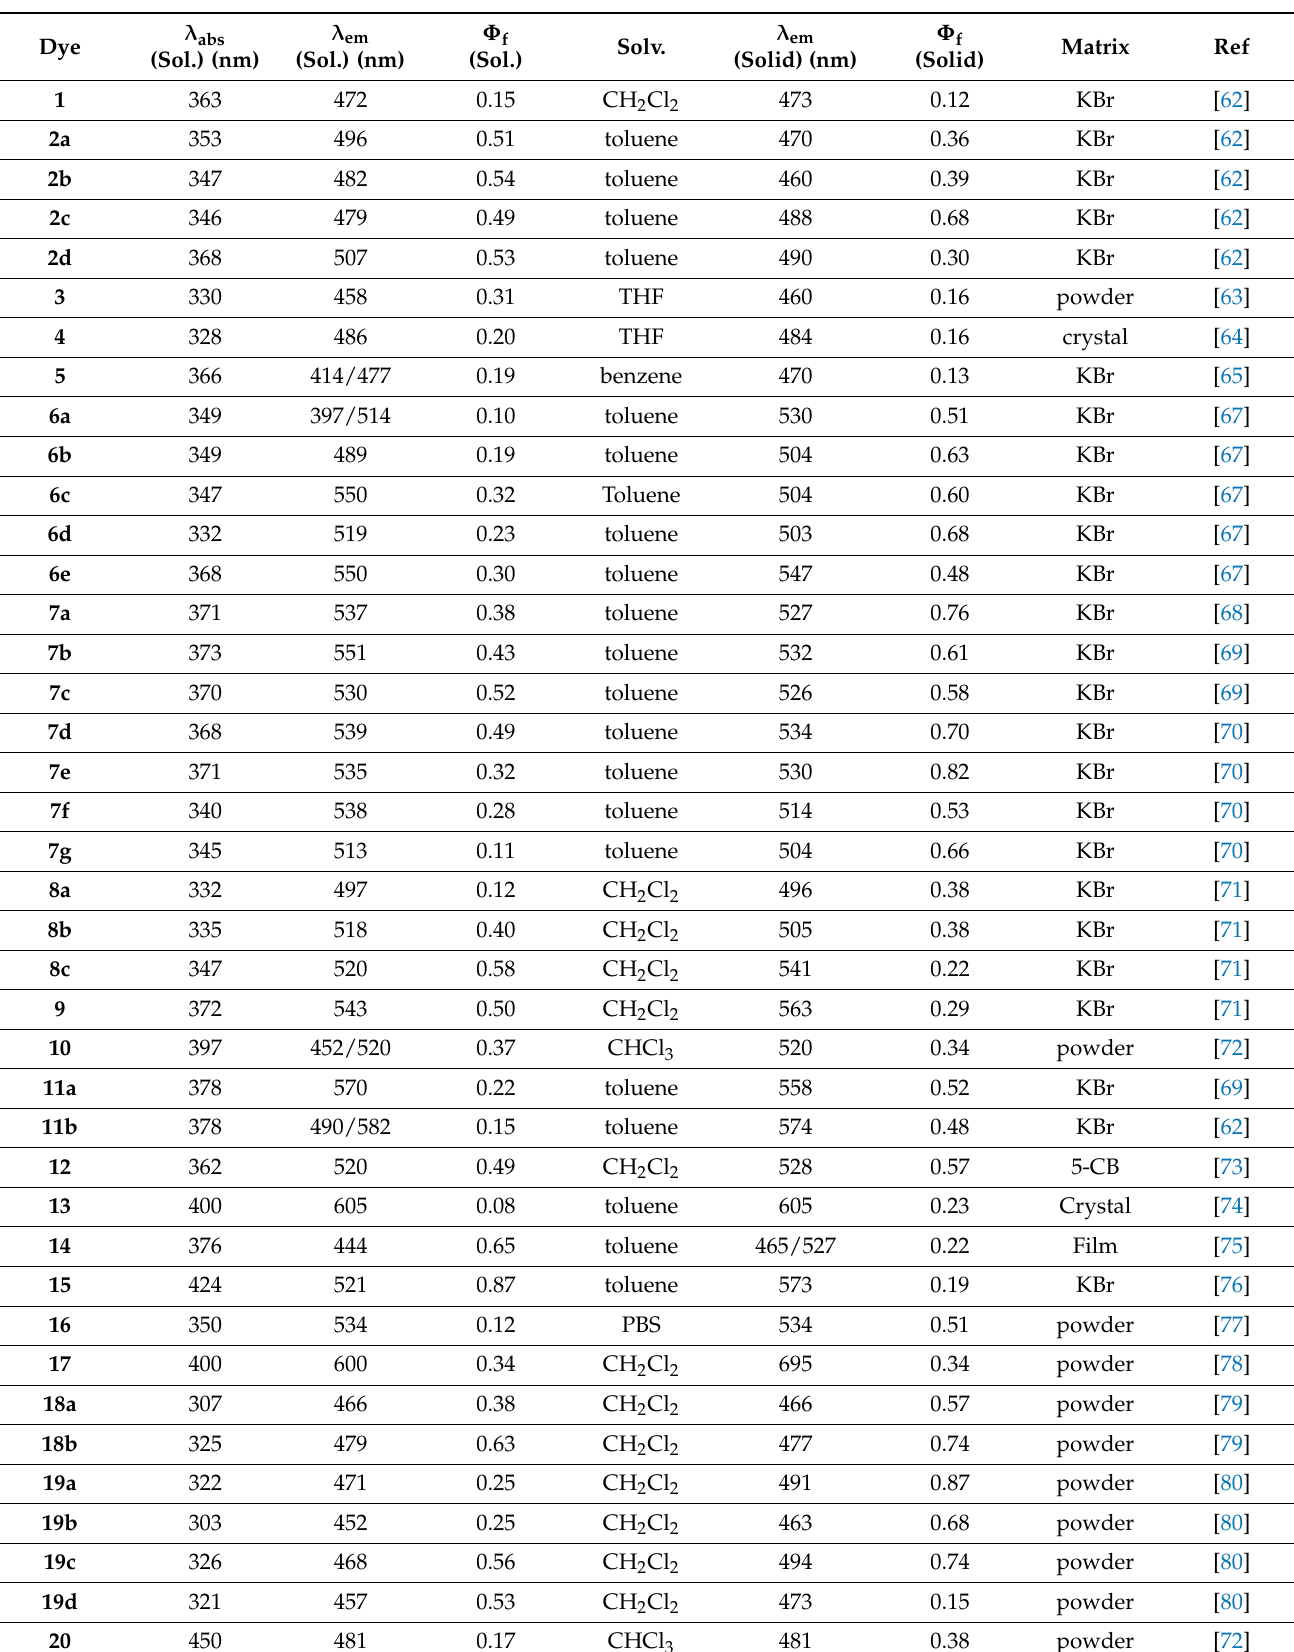
Table 1. Photophysical data for all DSE/ESIPT dyes in solution and